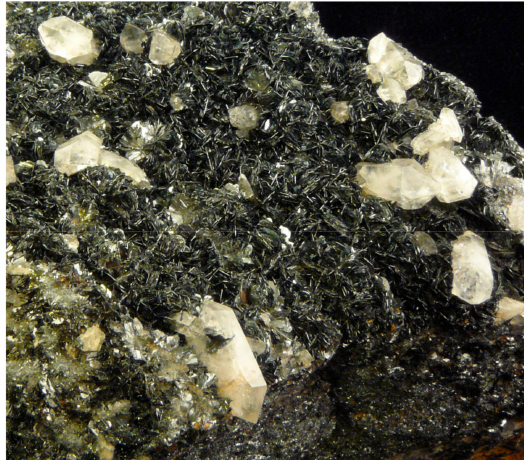
Figure 27. Quartz and hematite, Whitton prospect. Field of view, 7 cm. Chamberlain Collection, NYSM 11651.